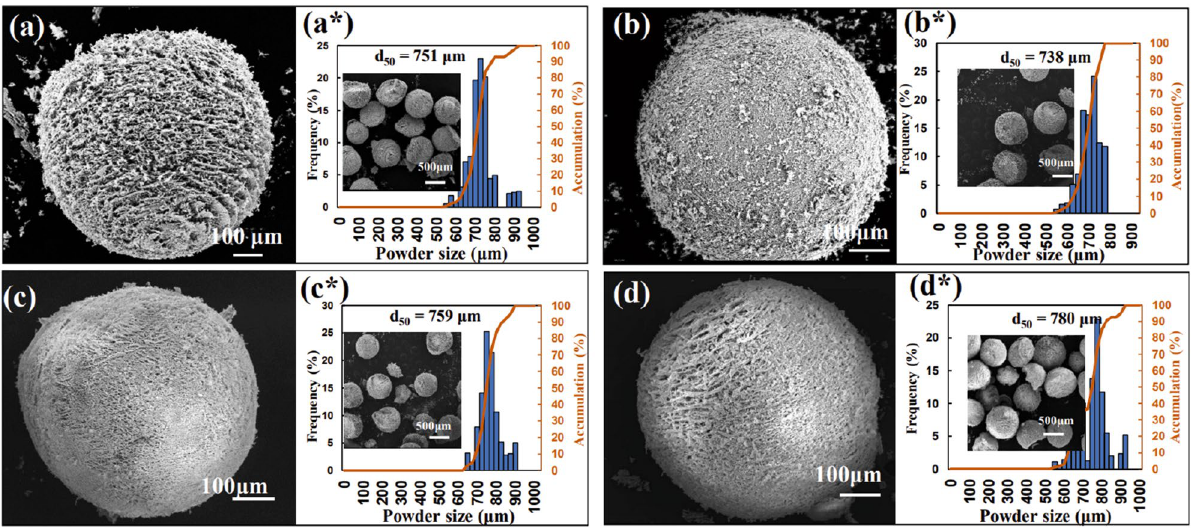
Figure 7. The SEM images and size distribution of the FD-POEM particles ( a : Mo-10at%Si; b : Mo-30at%Si; c : Mo-50at%Si; d : Mo-70at%Si). The inserts were low-magnification